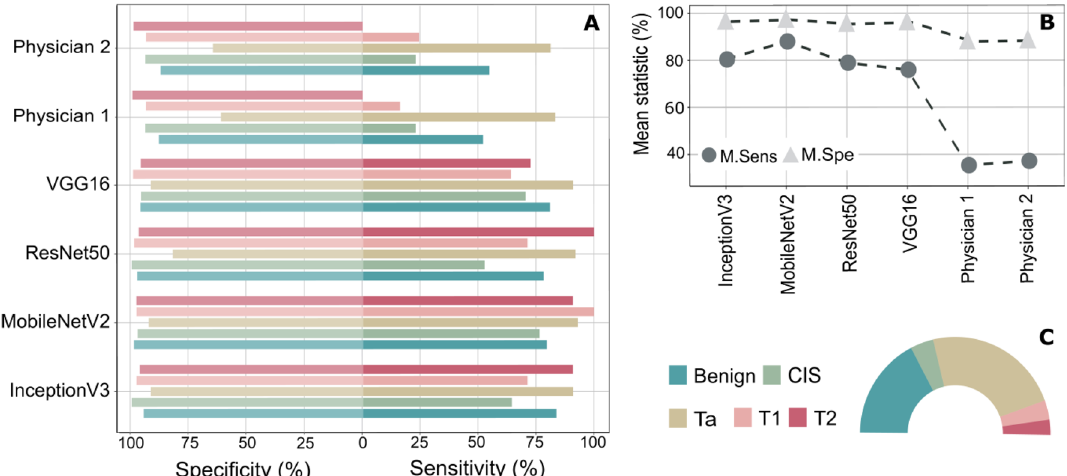
Figure 2. The identification of bladder tumor stage using the fine-tuned CNNs and urologist ratings. ( A ) The class sensitivities and specificities of the considered CNNs and both physician ratings as a two-directions bar chart. While both urologists could not assess well the last two invasive stages of bladder cancer, the detection of these tumor stages was quite good based on all CNNs ( B ) The obtained mean sensitivities and mean specificities for all classification models. The best classification results were achieved by the MobileNetV2 network with a mean sensitivity of 88% followed by the mean sensitivity obtained by the InceptionV3 network. The classification mean sensitivity decreased at least 50% when the same images were assessed by the urologists. ( C ) The class distribution of the BL image data set. The number of involved images for this task varies a lot from one class to another class.